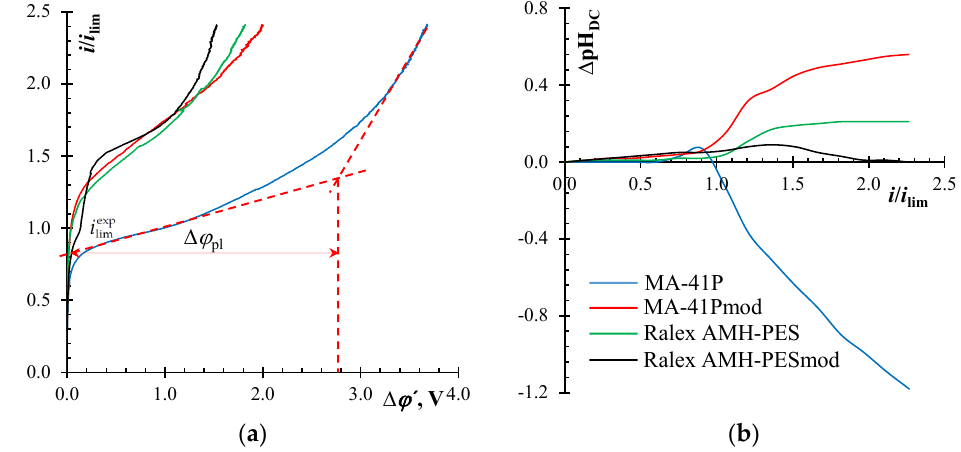
Figure 6. Current-voltage curves of the anion-exchange membranes under study ( a ), as well as differences in the pH of the inlet and outlet solution in the desalination chamber ( ∆ pH DC ) ( b ). ∆φ ’ is reduced potential drop (see Appendix A).